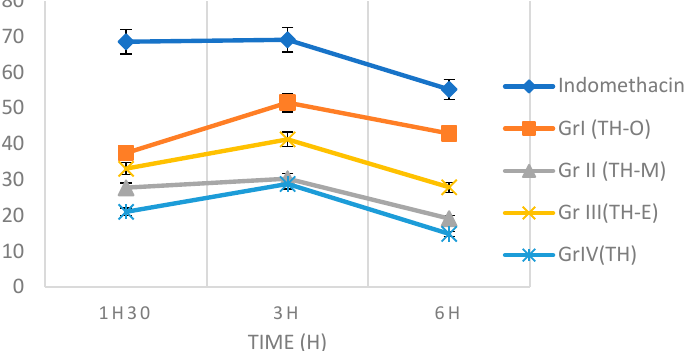
Figure 1. Effects of indomethacin, Thyme honey and mixtures on carrageenan-induced rat paw edema. TH: Thyme honey; TH-O: mixture of honey and O. vulgare EO; TH-M: mixture of honey and M. spicata EO; TH-E: mixture of honey and E. globulus EO.